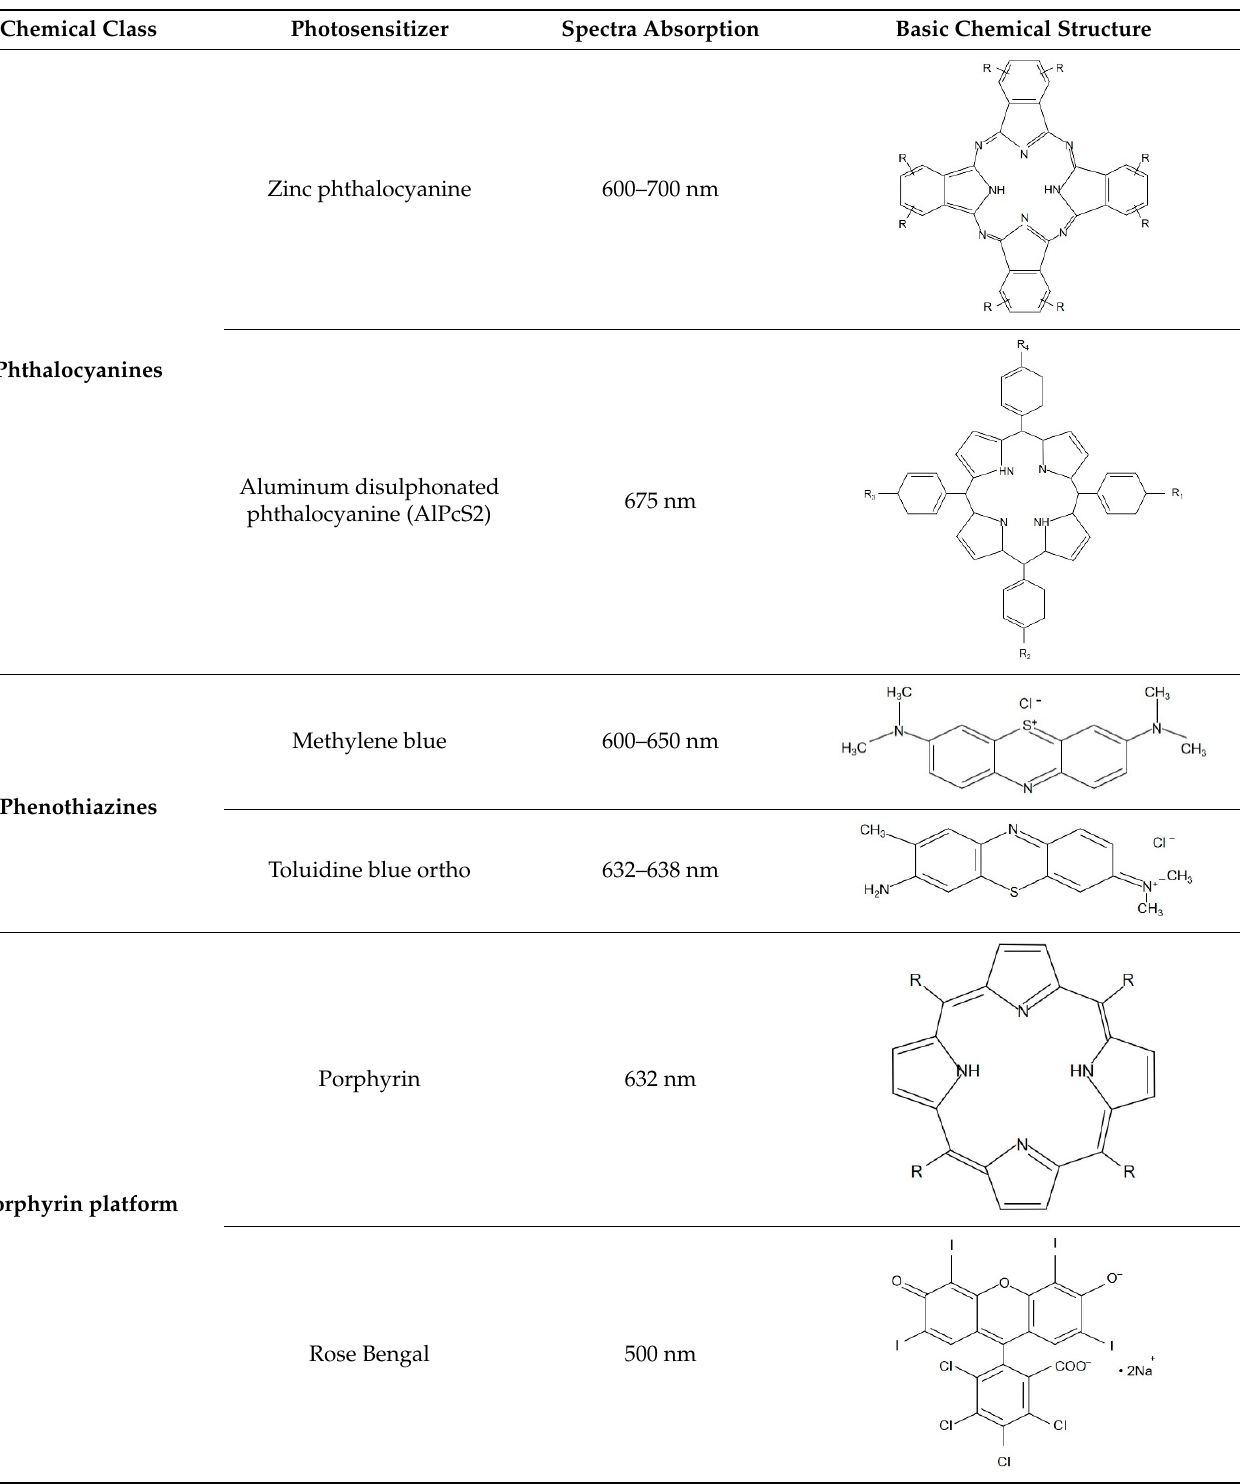
Table 1. General features of main photosensitizers used in aPDT against oral